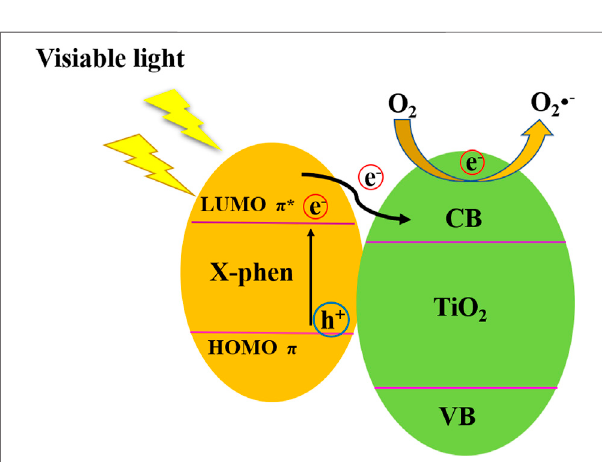
FIGURE 7 | Mott – Schottky plots of TiO 2 , Phen/TiO 2 , NO 2 -Phen/TiO 2 , and NH 2 -Phen/TiO 2 .